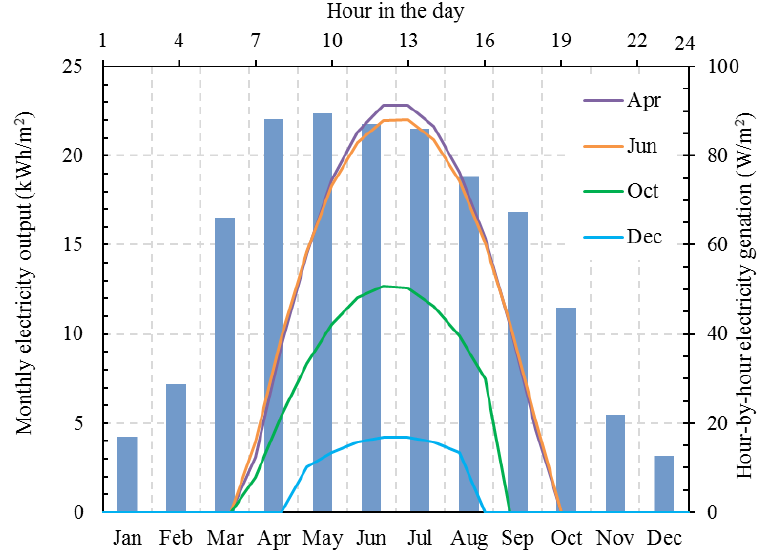
Figure 5. Hour-by-hour power output and monthly energy production per a unit area of Solar World SW325XL on the inclined surface (47 slope angle and 188 azimuth angle).